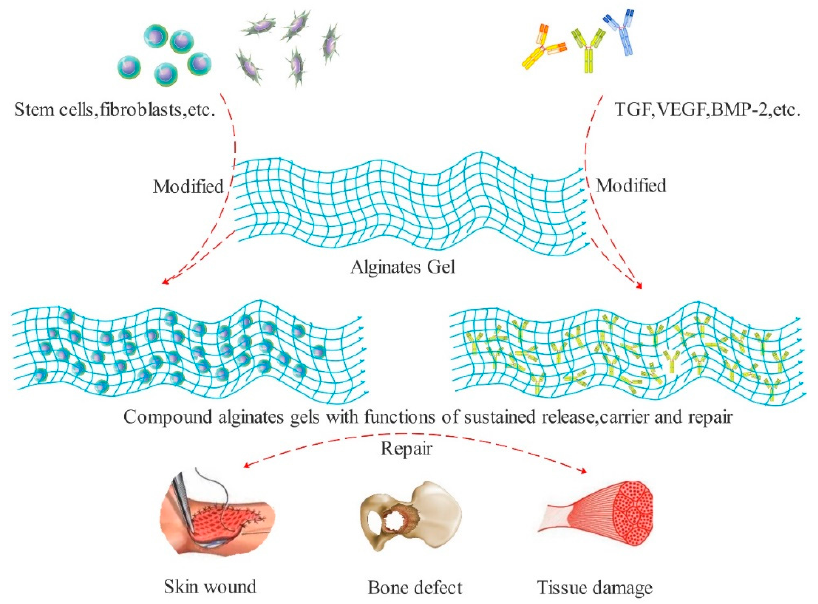
Figure 3. Wound regeneration mechanism of alginate gel which repairs using carry cells, factors,